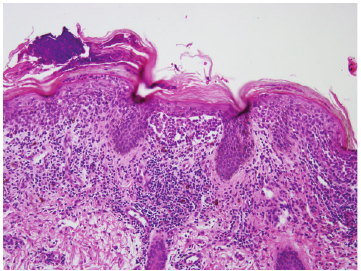
Figure 7: Skin biopsy, H&E stain ( × 200): dense deposit of Langer- hans cells with eosinophilic cytoplasm and indented nuclei in the superficial dermis and epidermis highlights